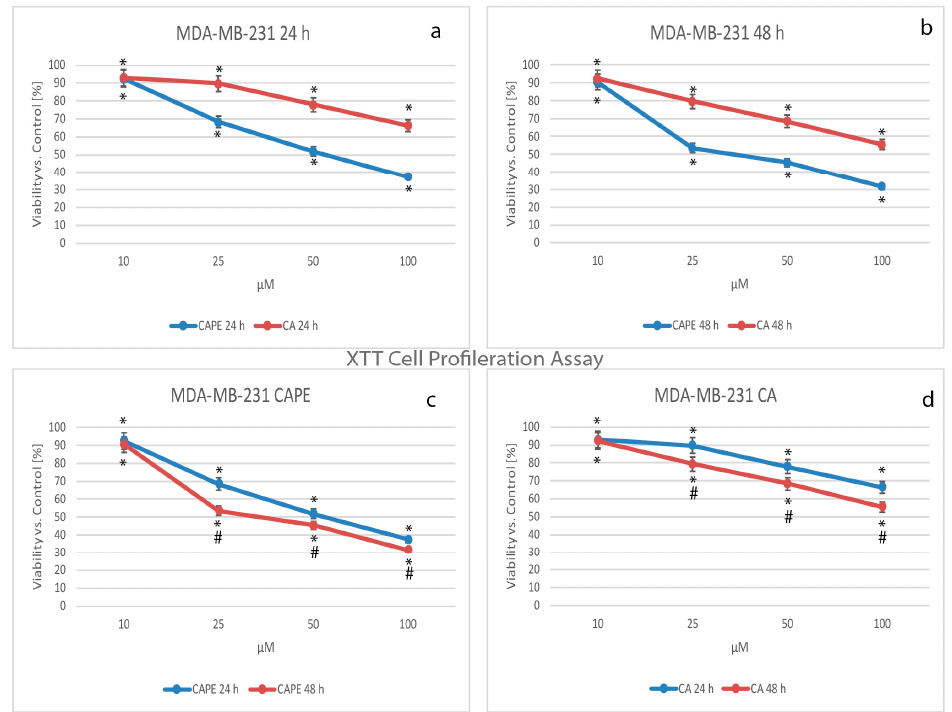
Figure 2. Cytotoxic effects of caffeic acid phenethyl ester (CAPE) and caffeic acid (CA) were both tested using concentrations of from 10 to 100 µM with 24 h and 48 h incubation times on the breast cancer cell line MDA-MB-231 using XTT (2,3-bis[2methoxy-4-nitro-5-sulfopheny]-2H-tetrazolium-5-